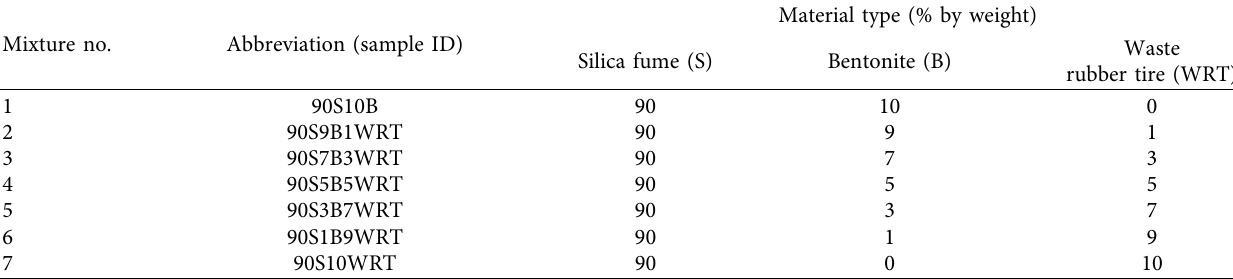
Table 3: Mixture design of the materials.